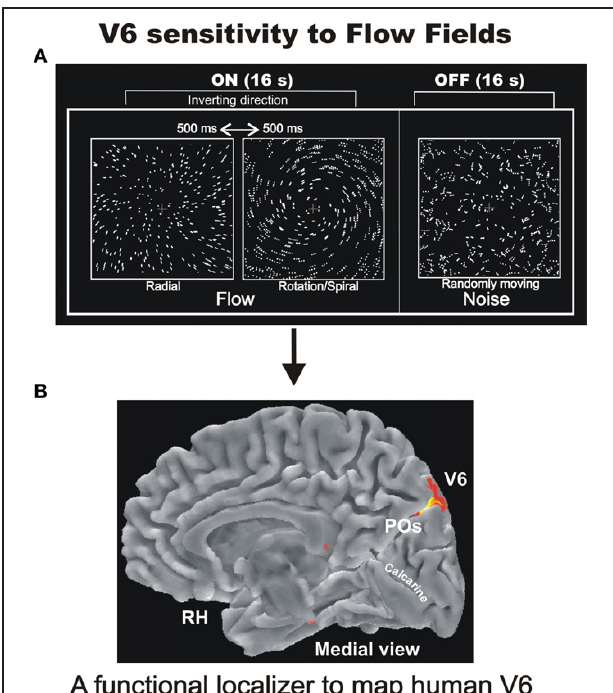
FIGURE 6 | Sensitivity of human V6 to Flow Fields. (A) Flowfields stimulus. The two frames of the ON phase show the two different types of coherent motion (radial and rotation/spiral motion) that switched almost every 500ms and were compared to random motion presented during the OFF phase. For both radial and spiral motion, we tested both expansion and contraction components [modified from Pitzalis et al. (2010)]. We used a wide field stimulation (up to 110 ◦ ) and the subjects were instructed to fixate the central red cross to minimize eye movements. See methods in Pitzalis et al. (2010) for further details. (B) Area V6 mapped with the flowfields stimulus as a functional localizer. Results are displayed on the medial folded representation of the right hemisphere (RH) of the template brain. POs, parieto-occipital sulcus. Modified from Sdoia et al.